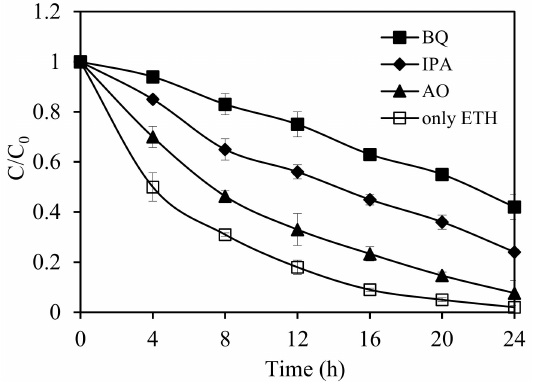
Figure 8. Photocatalytic degradation of ethiofencarb with SnIn 4 S 8 catalyst in the absence and presence of scavengers (IPA, AO, and BQ) under visible-light irradiation. Experimental conditions: ethiofencarb concentration 10 mg L − 1 ; SnIn 4 S 8 concentration 0.5 g L − 1 ; scavenger concentration 1 × 10 − 3 M; pH